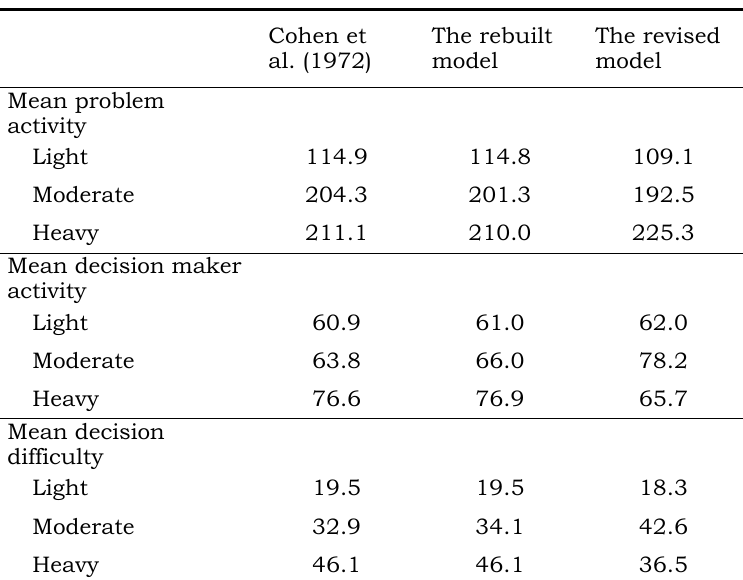
Table 2. Genuine results of the garbage can